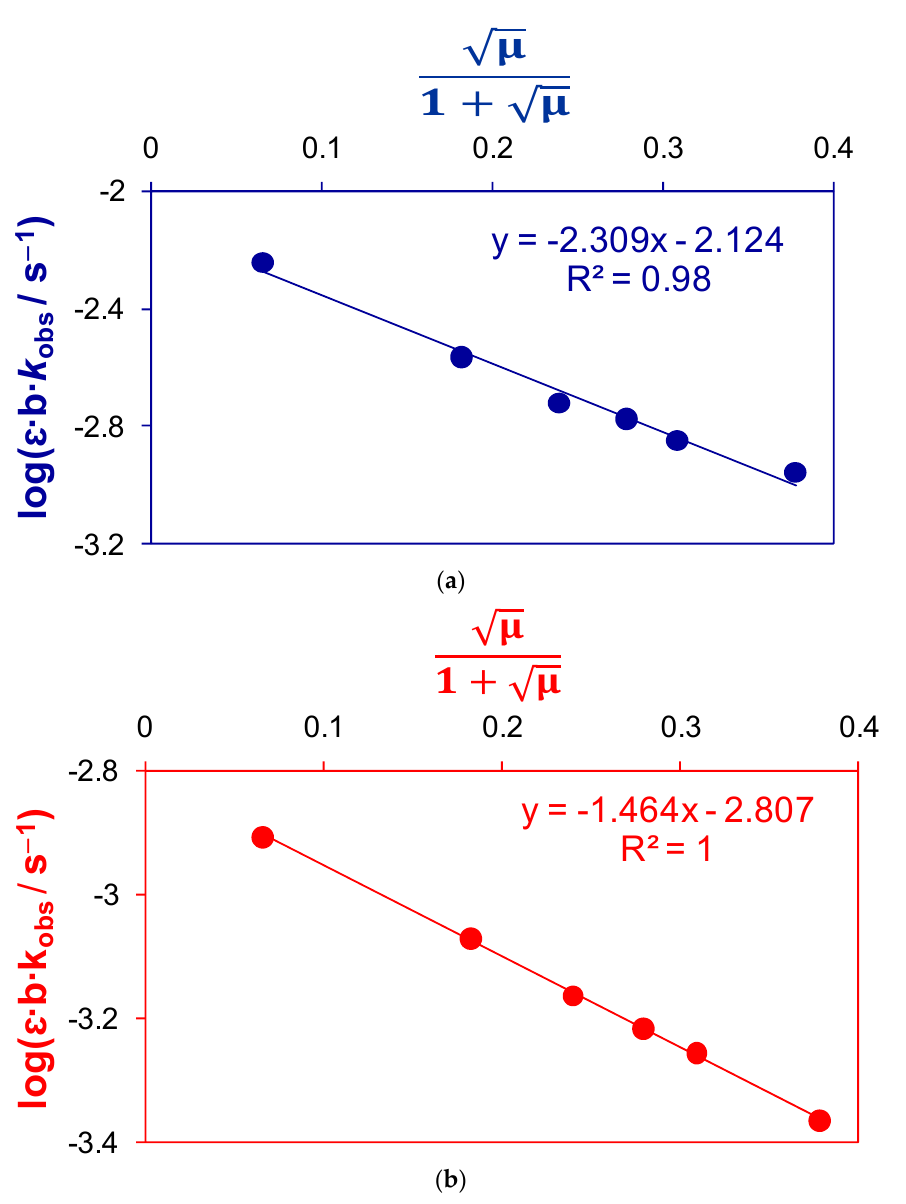
Figure 9. ( a ) Plot of the effect of ionic strength on the observed rate constant in 10% v / v dioxane-water at 288 ± 0.5 K. ( b ) Plot of the effect of ionic strength on the observed rate constant in 20% v / v dioxane-water at 289 ± 0.5 K.